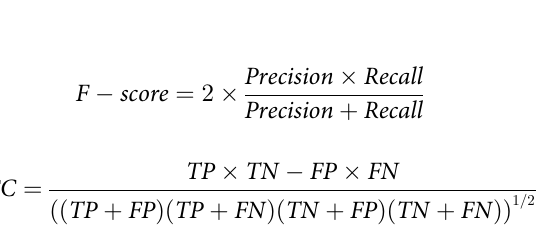
Fig 1. Block diagram showing the various dataset inputs to the DL models and their corresponding dataset-specific predictions.